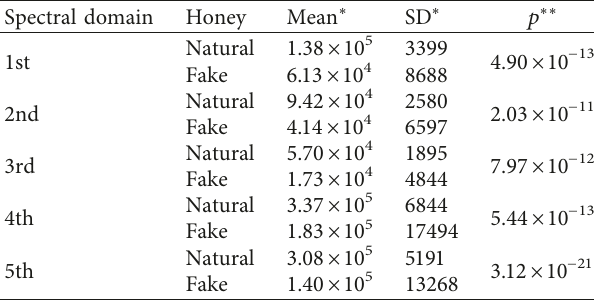
Table 2: Statistical analysis mean values, standard deviation: SD, and statistical significance of difference between means: p of five spectral domain volumes (marked on Figure 1) in EEMs of 99 natural and 15 fake